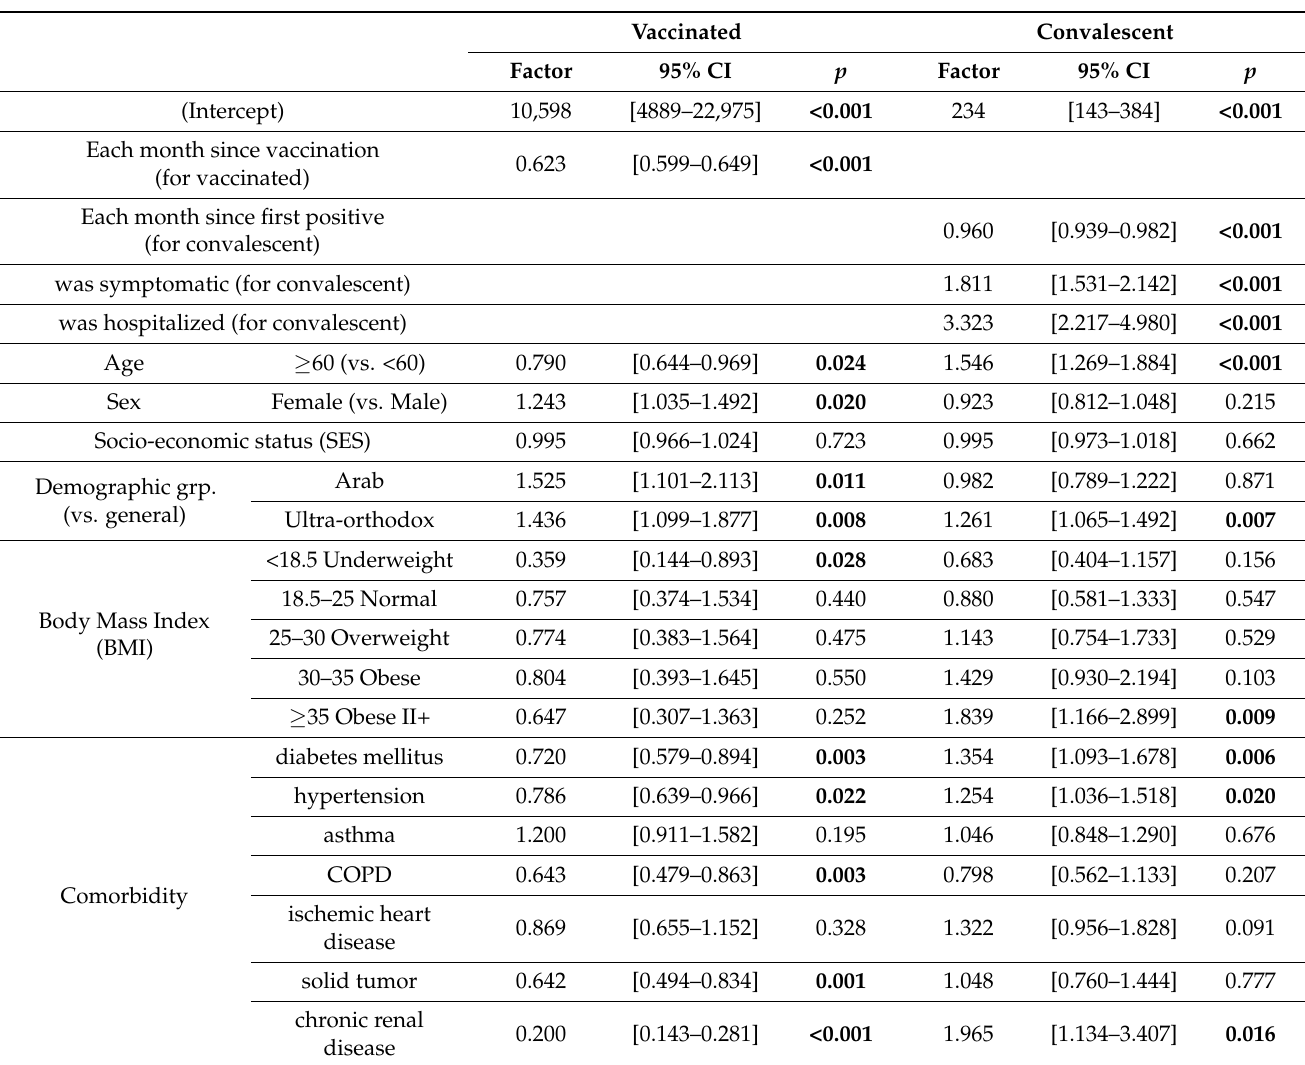
Table 4. Linear regression models of SARS-CoV-2 IgG antibody titer assuming linear decay with time. Regression coefficients were obtained by fitting a multivariable linear regression model for the log of antibody titer. They are displayed after exponentiation; they are therefore multiplicative: the expected antibody titer equals the intercept multiplied by each factor. Significant p -values are shown in bold